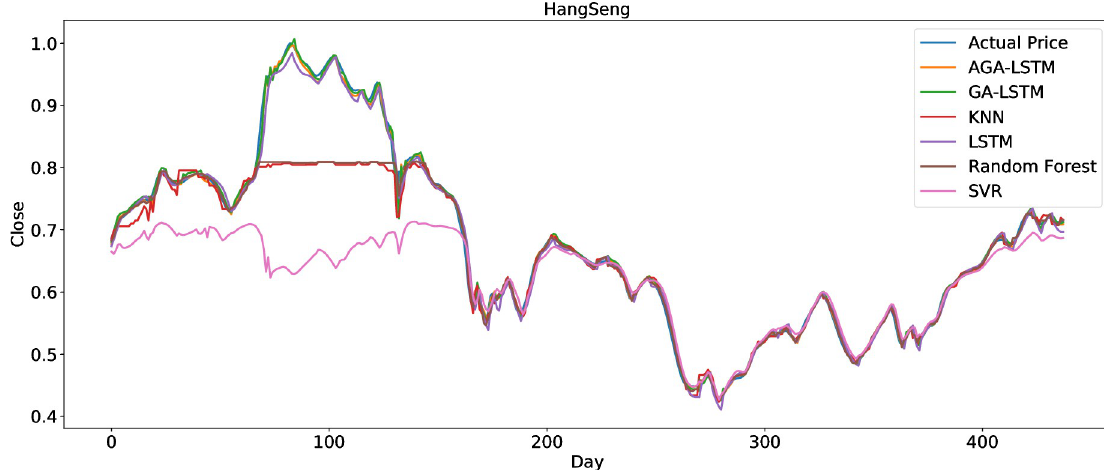
Fig 20. Comparison of AGA-LSTM and other DL models in HangSeng data set.